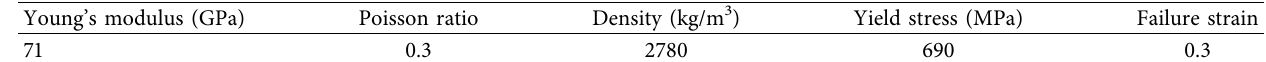
Figure 3: The finite element model: (a) top view; (b) front view. Table 1: Material parameters of flat plate.